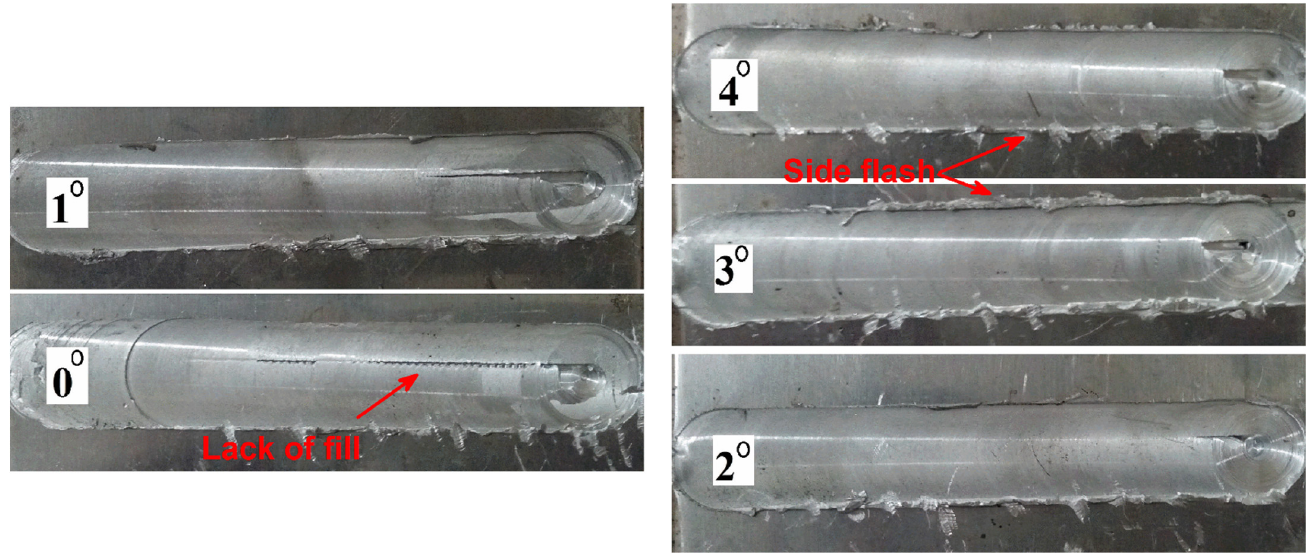
Figure 8. Welded specimens with various tilt angles.